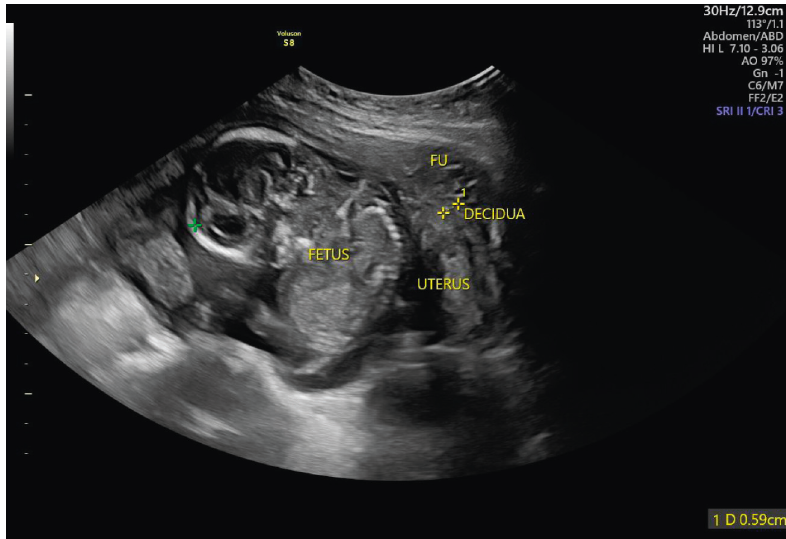
Figure 1: Ultrasonographic image of the abdominal